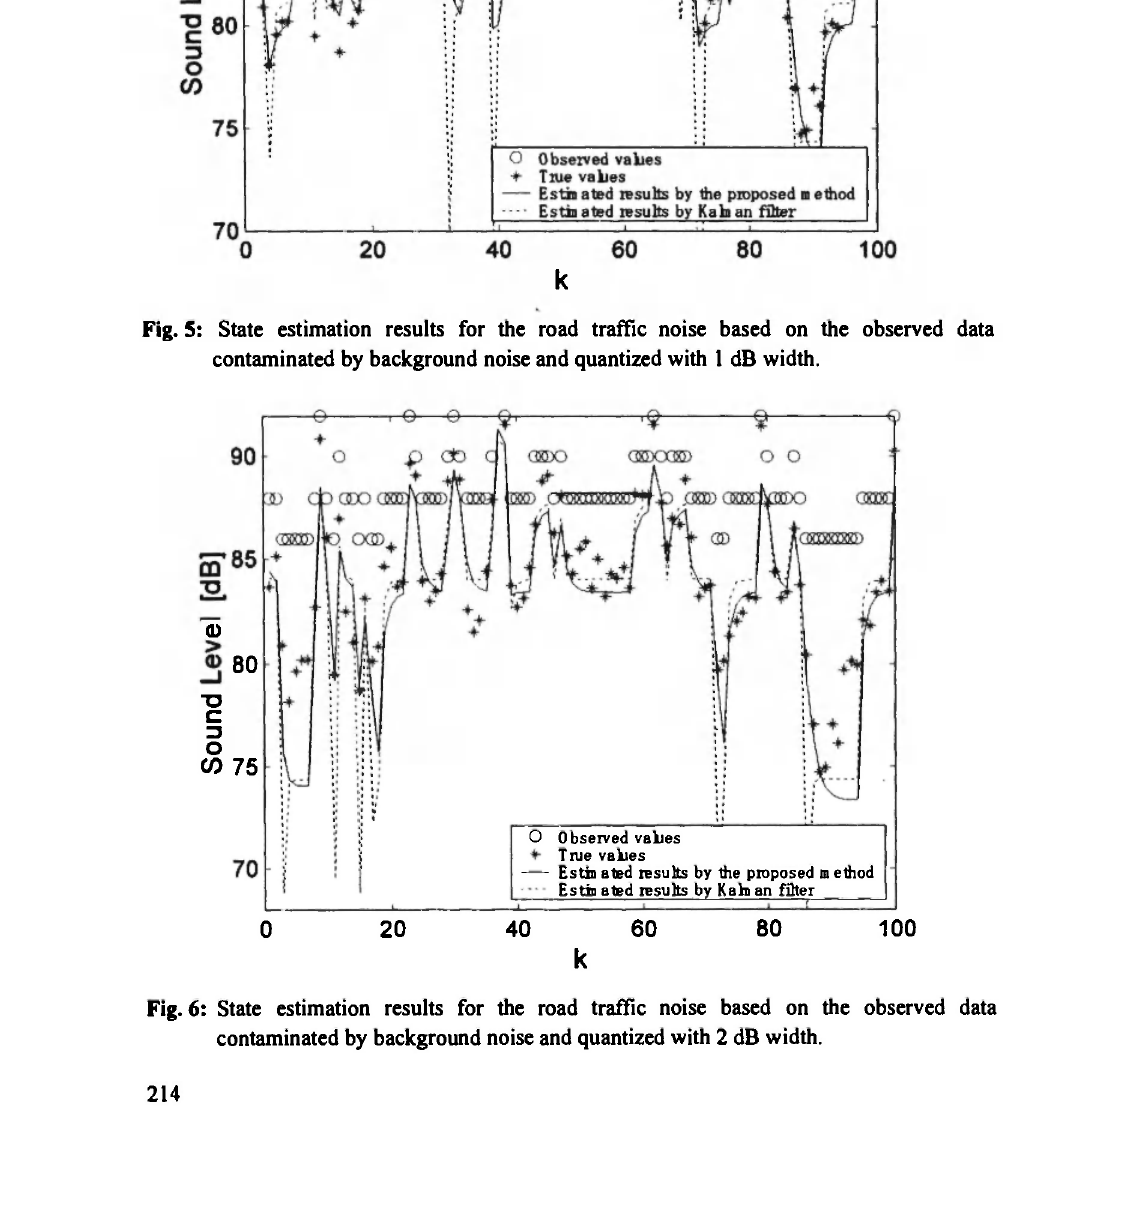
Fig. 6: State estimation results for the road traffic noise based on the observed data contaminated by background noise and quantized with 2 dB